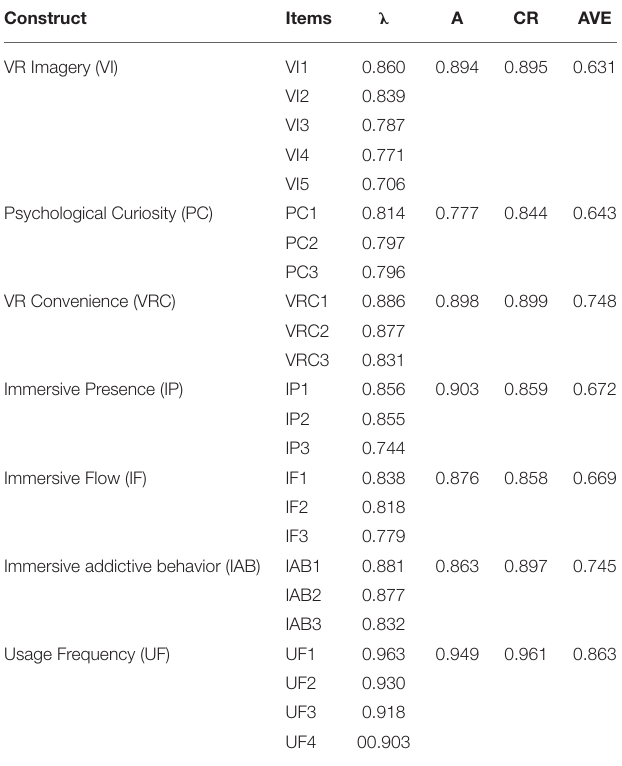
TABLE 3 | Exploring factors and reliability analysis. Construct Items λ A CR